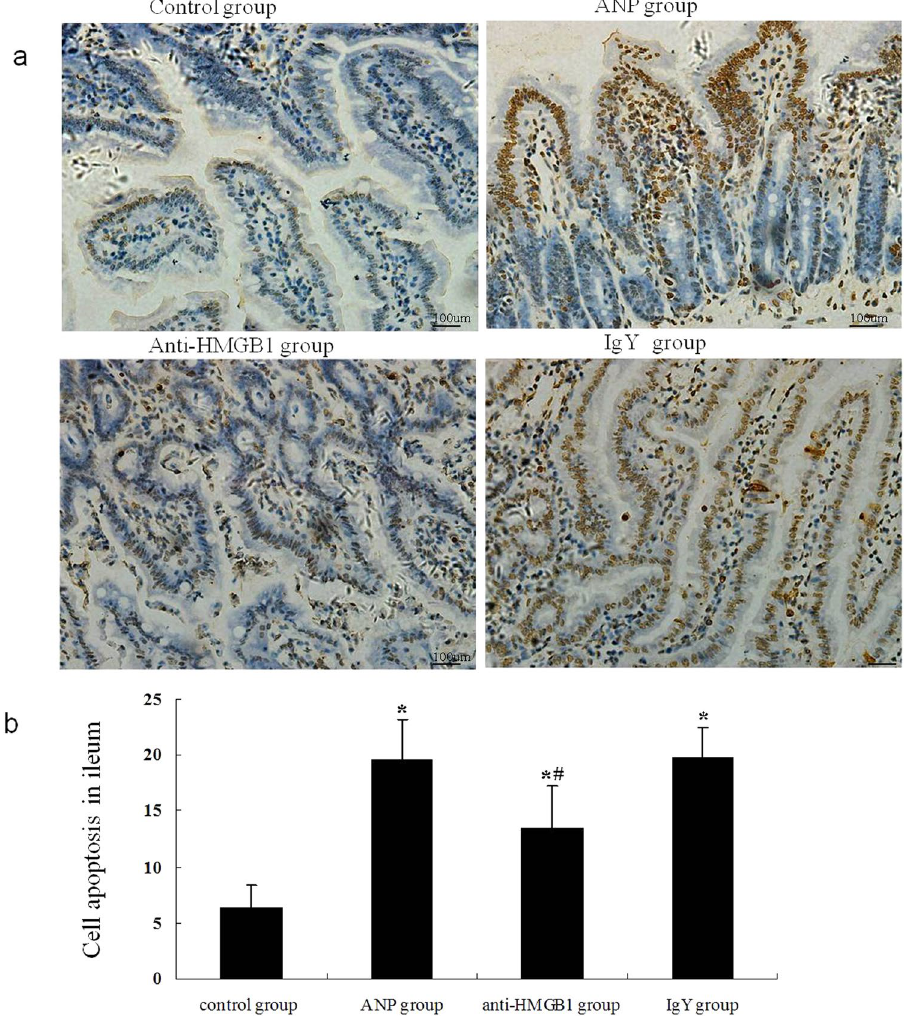
Figure 6. Apoptosis of ileal mucosal cells detected by TdT-mediated dUTP nick end labeling assay. ( a ) DAB staining, light microscopy, original magnification x200. The apoptotic cell was characterized by brown colored nuclei. ( b ) Comparison of ileal epithelial cell apoptosis in the different groups. The detection of apoptosis was semiquantified as defined in the “Materials and Methods” section. Data (IOD value) expressed as mean ± SD (n = 10 animals per group). * P < 0.05 versus control group. # P < 0.05 versus ANP